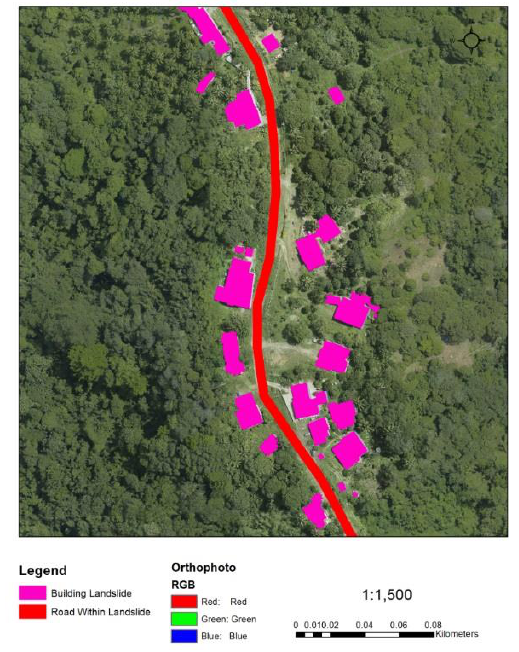
Figure 2: Example of element at risk (building and